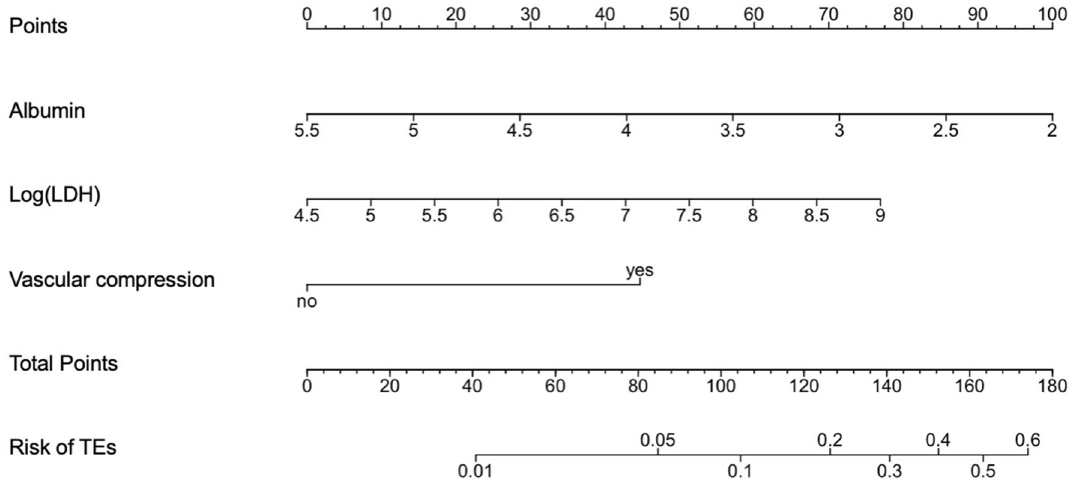
Figure 2. Nomogram predicting the probability of developing a TE during hospitalization and in the next 45 days after discharge. Log(LDH) natural logarithm lactate dehydrogenase, TEs thromboembolic events.